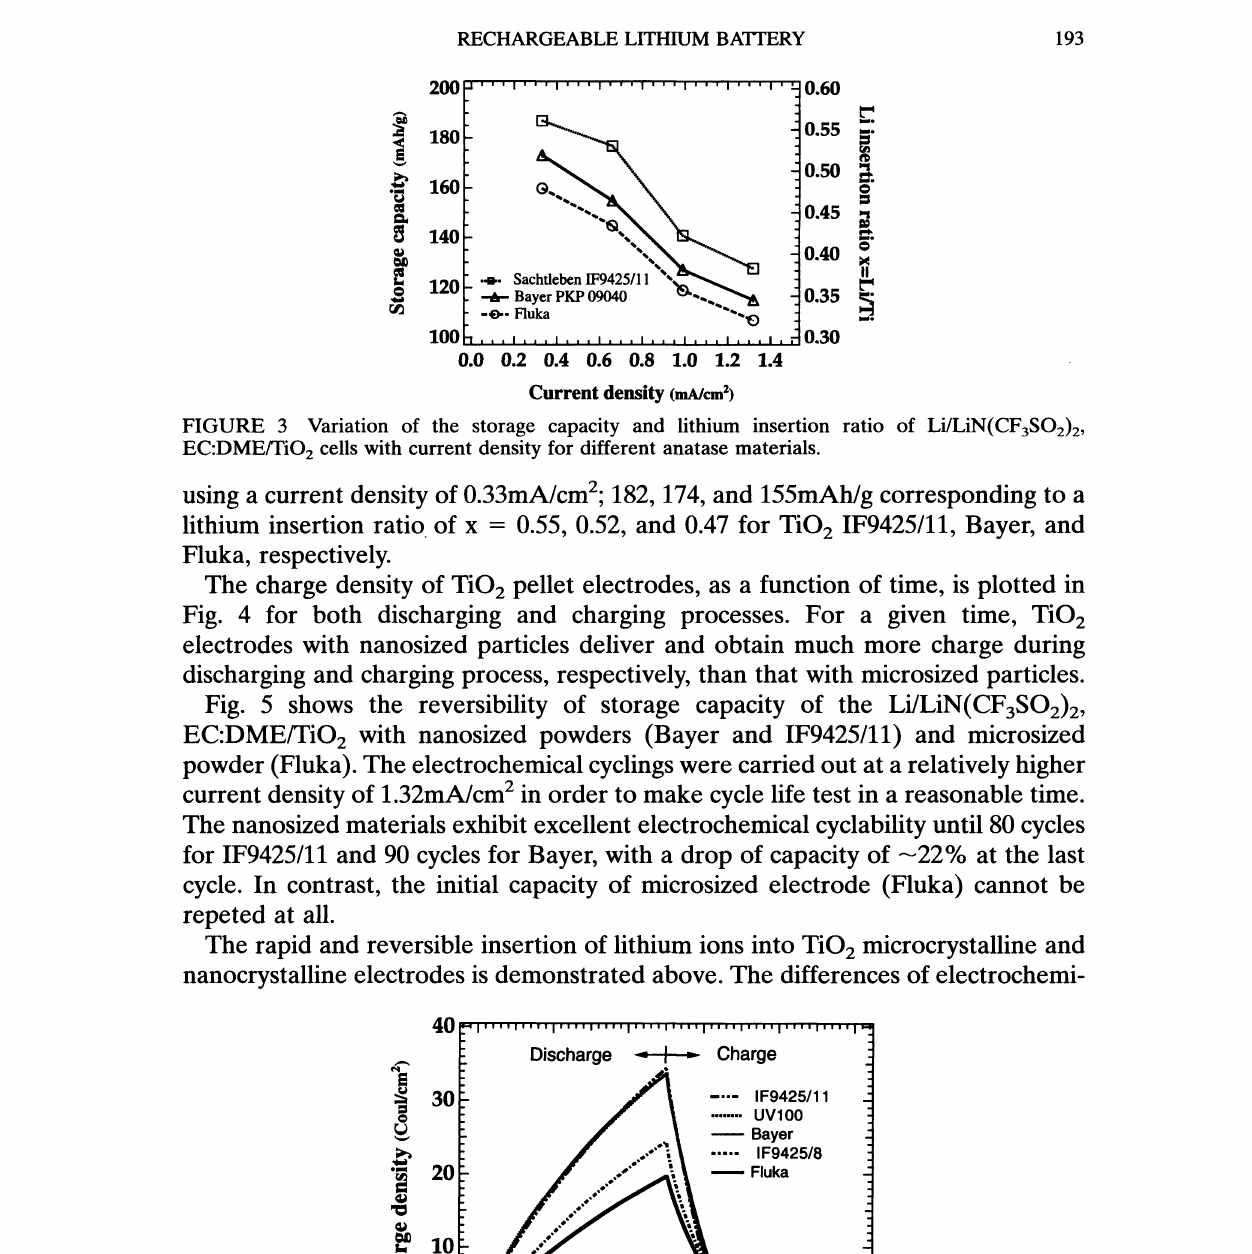
FIGURE 4 Charge density following a potential step from 3-1.5V for the Li/LiN(CF3SO2)2, EC:DME/TiO2 cells with different starting